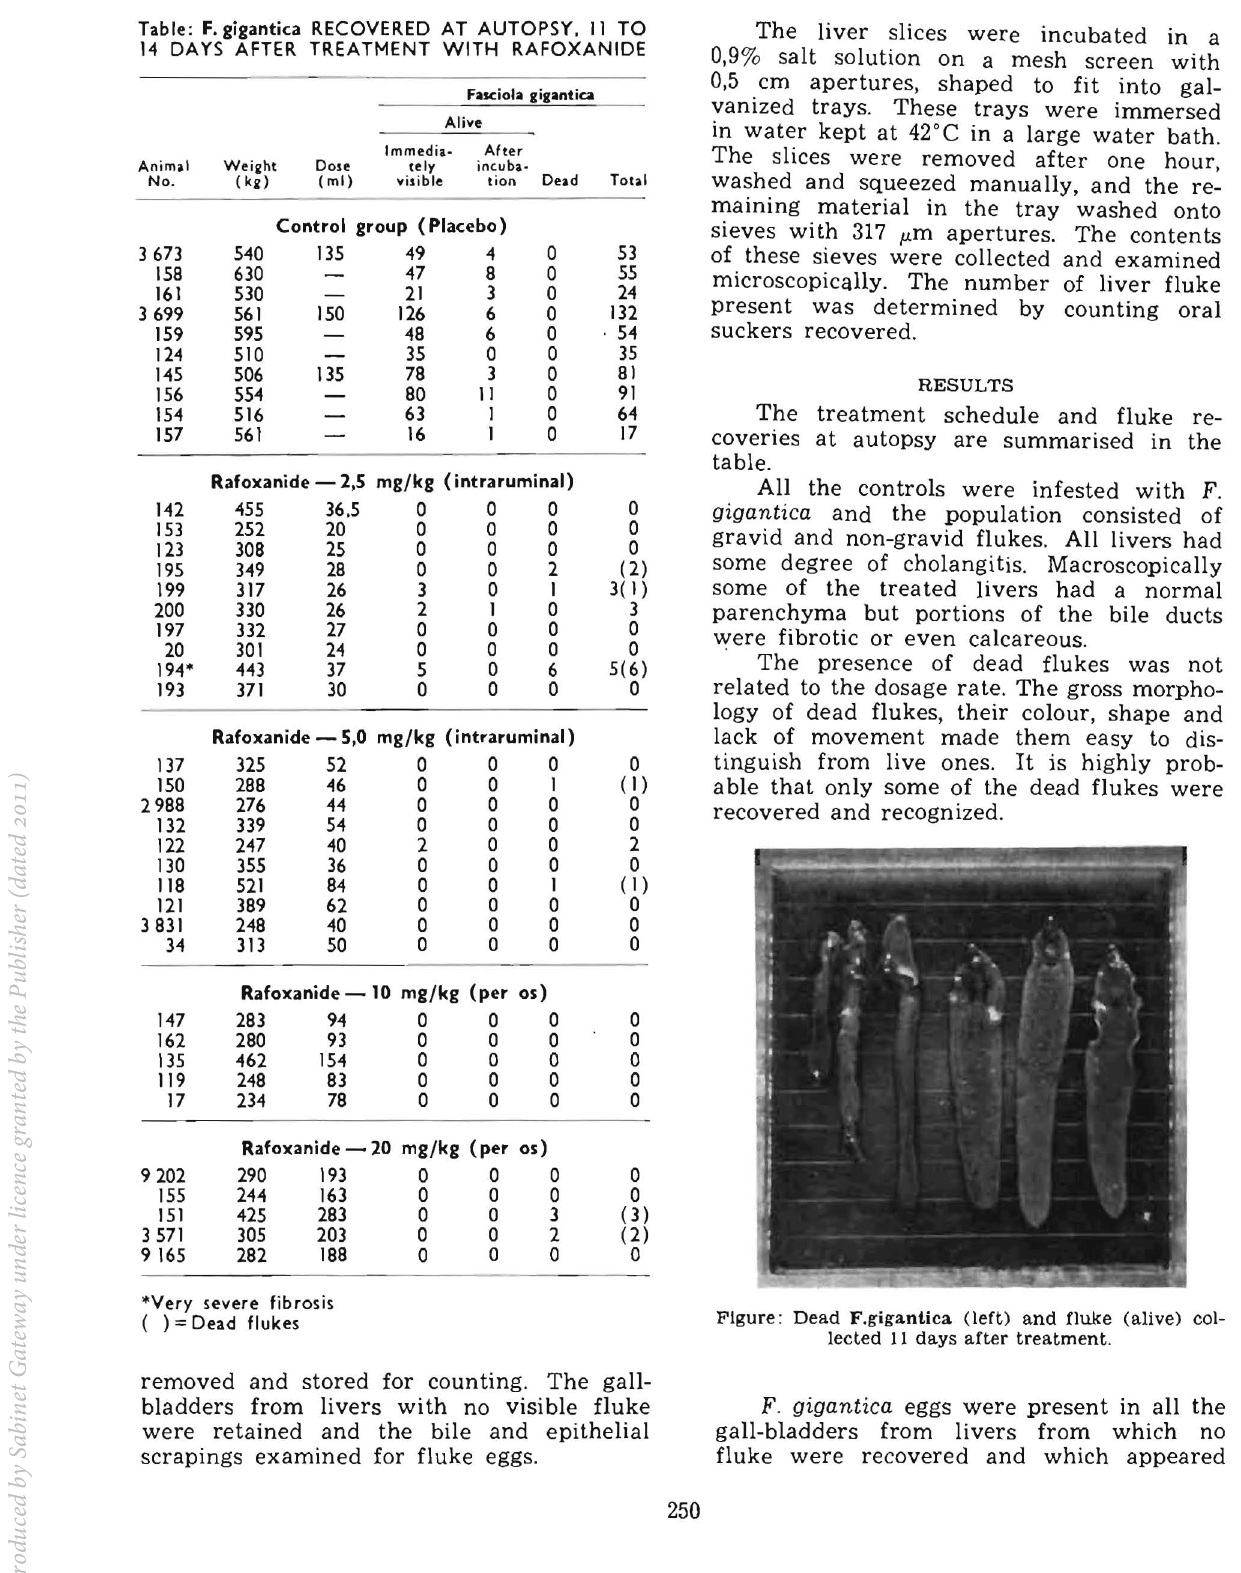
Table: F. gigantica RECOVERED AT AUTOPSY, II TO 14 DAYS AFTER TREATMENT WITH RAFOXANIDE Fasciola gigantica Ali.e Immedia- Aft.r Animal ,ely